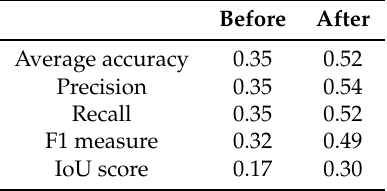
Table 3. Segmentation metrics on the target dataset before and after the implementation of our algorithm.